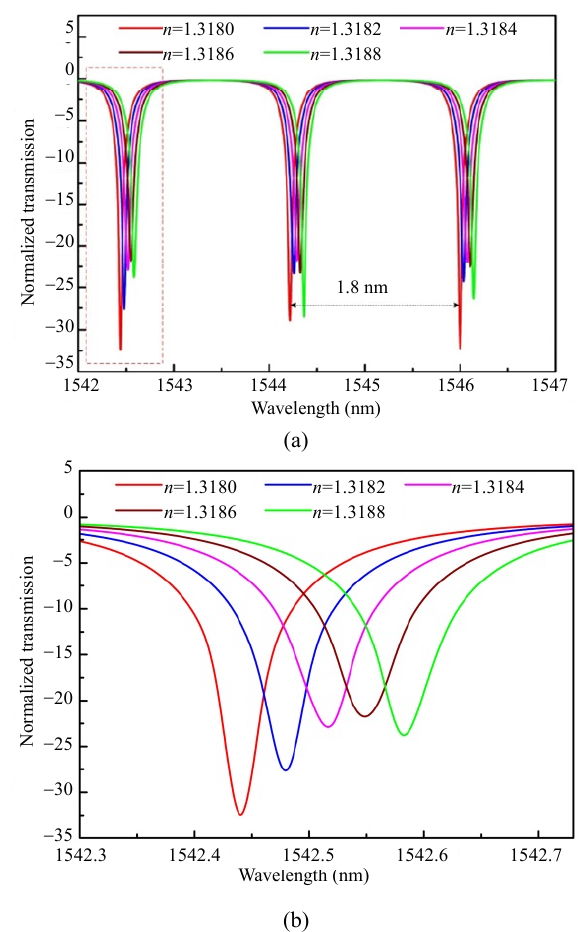
figure, the relationship between the resonant wavelengths versus refractive index of the tested